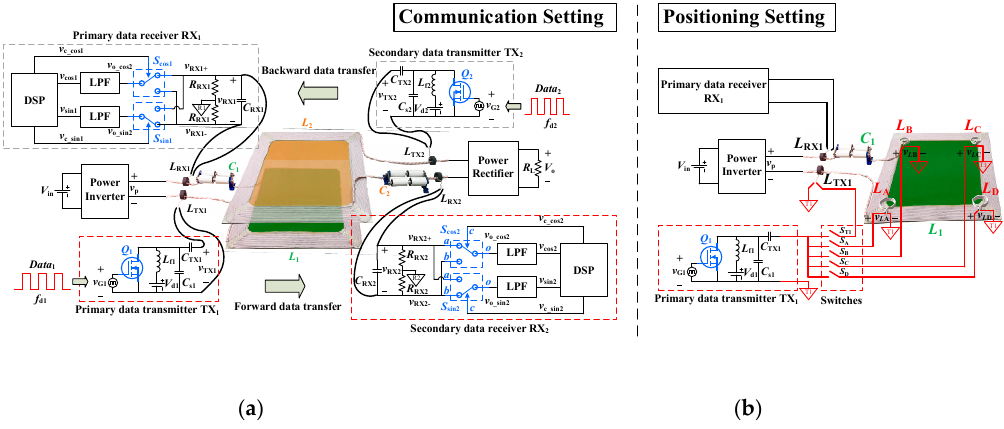
Figure 1. Simultaneous wireless power and data transmission (SWPDT) system: ( a ) original communication setting; ( b ) proposed positioning setting.